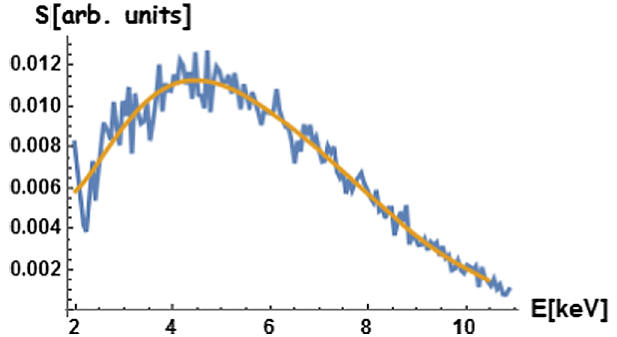
FIG. 2. Betatron spectrum detected with a CCD-X camera working in single photon counting mode together with a poly- nomial fit.